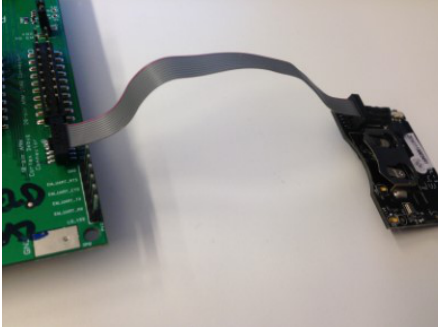
Figure A3. SmartRF06 evaluation board + TI CC2650 SensorTag.